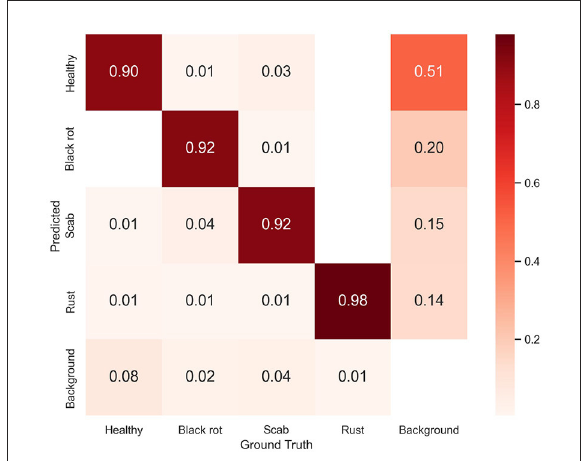
FIGURE10 The confusion matrix of identification results. The confusion matrix was normalized over the true (columns) condition for our proposed model. The horizontal axis represents the ground truth classes and the vertical axis represents the predicted classes. Each cell element represents the proportion of the number of the predicted class to the total number of the true class. The diagonal elements represent correctly classified outcomes. All other off-diagonal elements along a column are wrong predictions.